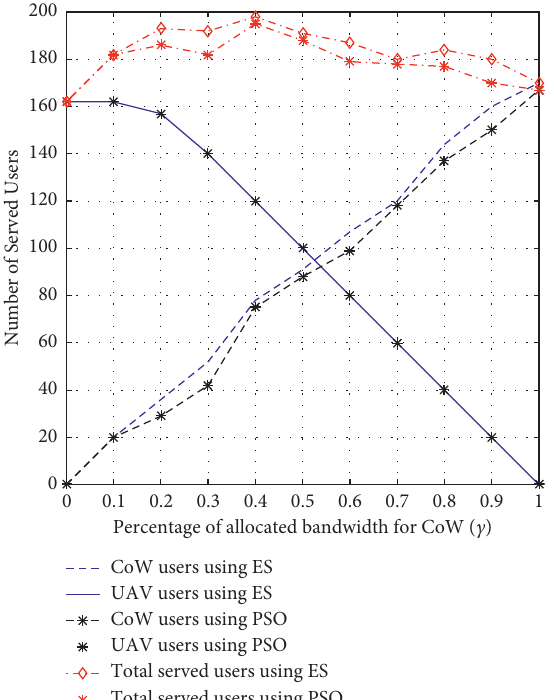
Figure 3: Number of served users using PSO and ES algorithms when the priority is given to the UAV at the